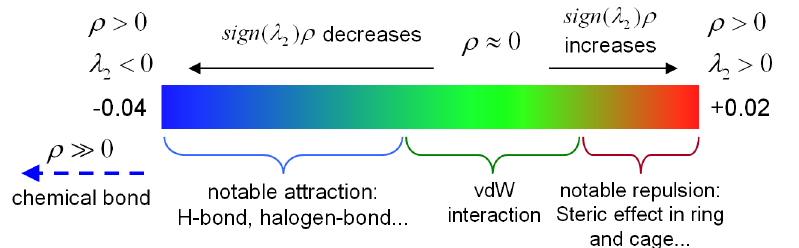
Figure 4. Standard coloring method and chemical explanation of sign( λ 2 ) ρ on IRI isosurfaces. λ 2 represents the sign of the second largest eigenvalue of the electron density Hessian matrix, and ρ is the electron density. When ρ > 0 and λ 2 < 0, the atoms in the molecule show notable attraction, which corresponds to the blue area. When ρ > 0 and λ 2 > 0, the atoms show notable repulsion, which corresponds to the red area. When ρ ≈ 0, it indicates van der Waals interaction, which corresponds to the green area. When ρ (cid:29) 0 and λ 2 < 0, sign( λ 2 ) ρ smaller than − 0.04, and a chemical bond is formed which is indicated by the blue arrow.